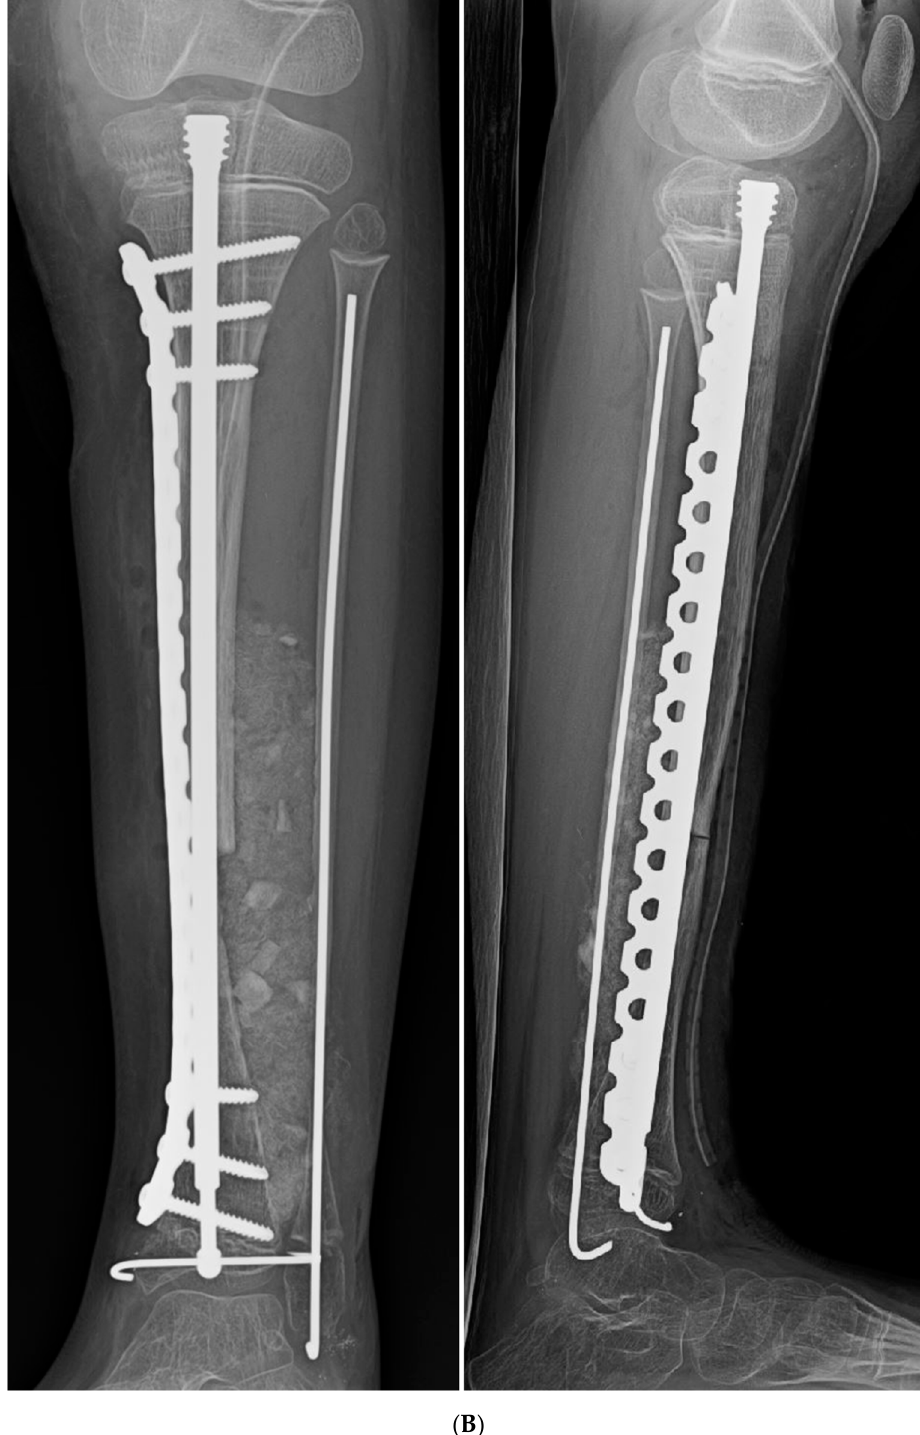
Figure 1. ( A ) AP and lateral radiographs that were taken postoperatively of a patient who underwent a Paley cross-union procedure performed with a circular external fixator. ( B ) AP and lateral radiographs that were taken postoperatively of a patient who underwent a Paley cross-union procedure performed with all internal fixation.